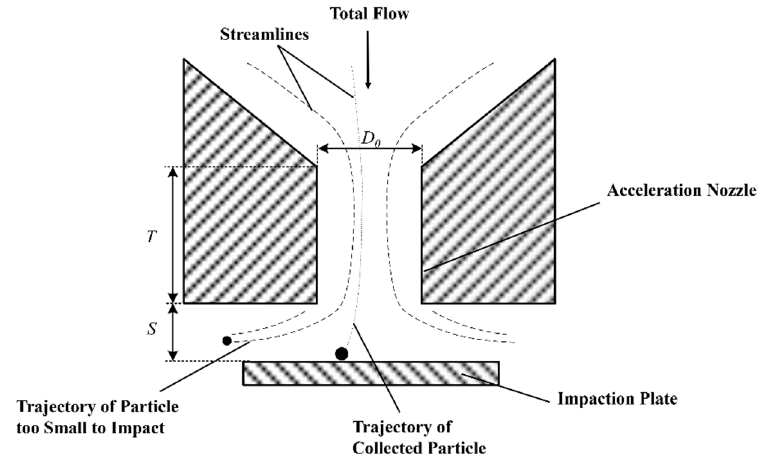
Figure 8. Schematic of the conventional impactor.